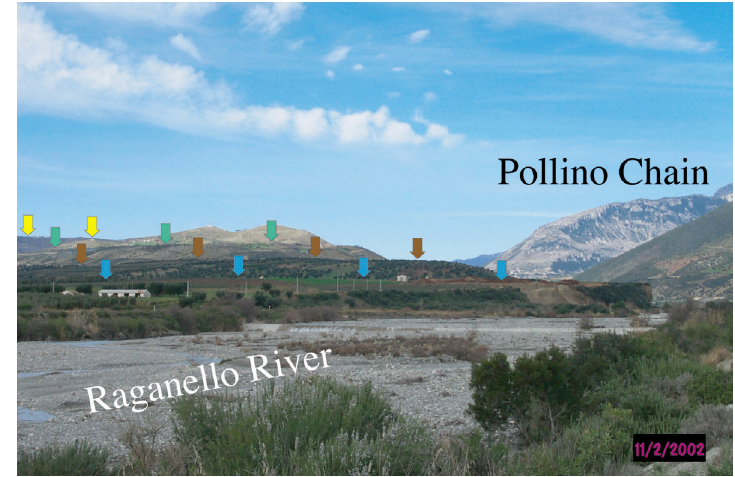
Fig. 4. Westward view of the terraces in the Lauropoli area; coloured arrows (same colours as fig. 2) point to terraces T#2 to T#5. Location of the photo in fig.